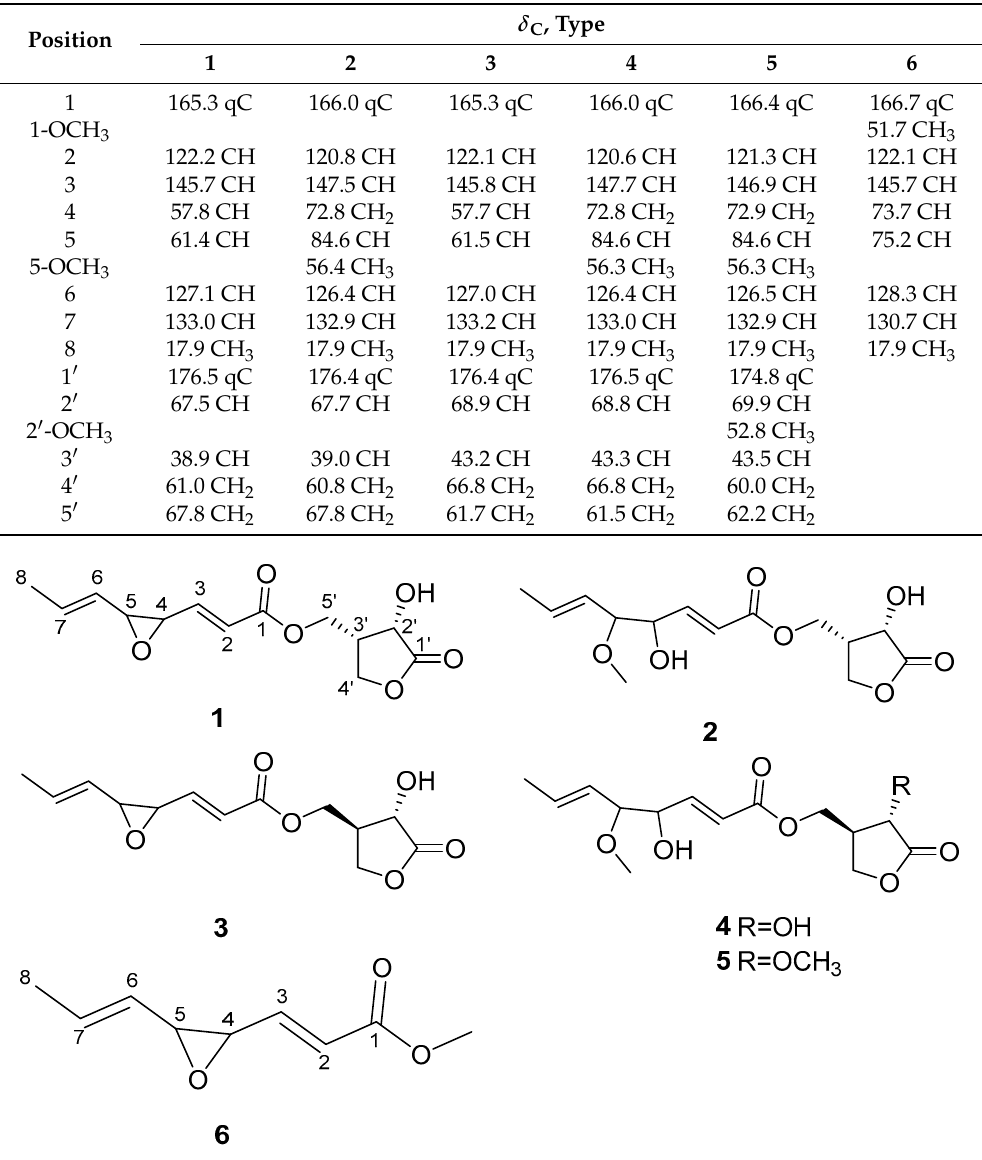
Figure 2. Structures of compounds 1 – 6. Table 1. 1 H (600 MHz) NMR data of compounds 1 – 6 in CDCl 3 .